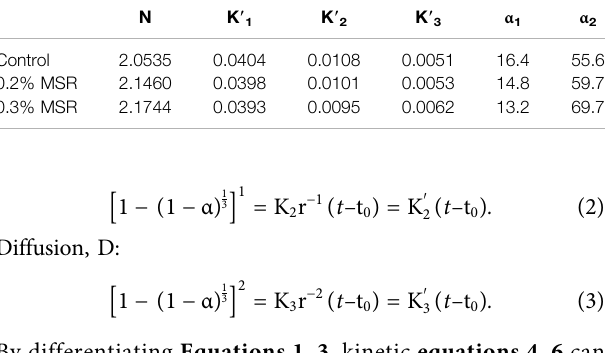
Frontiers in Materials |